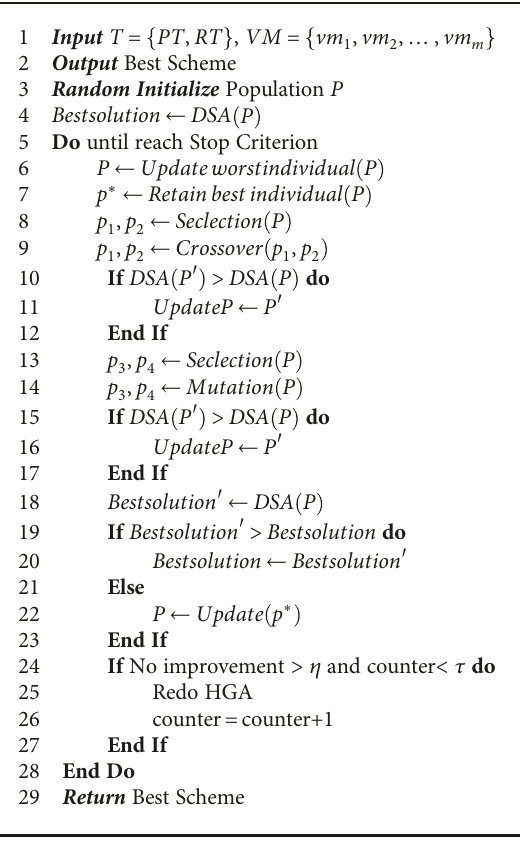
Algorithm 2: Heuristic genetic algorithm (HGA).